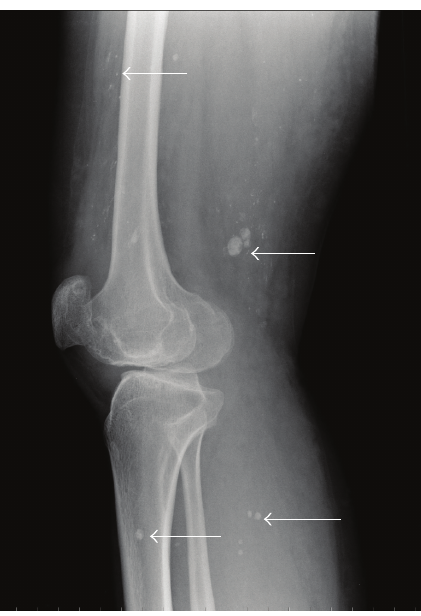
Figure 4: Lateral radiograph of the knee demonstrating multiple venous calcifications (phleboliths) (arrows).